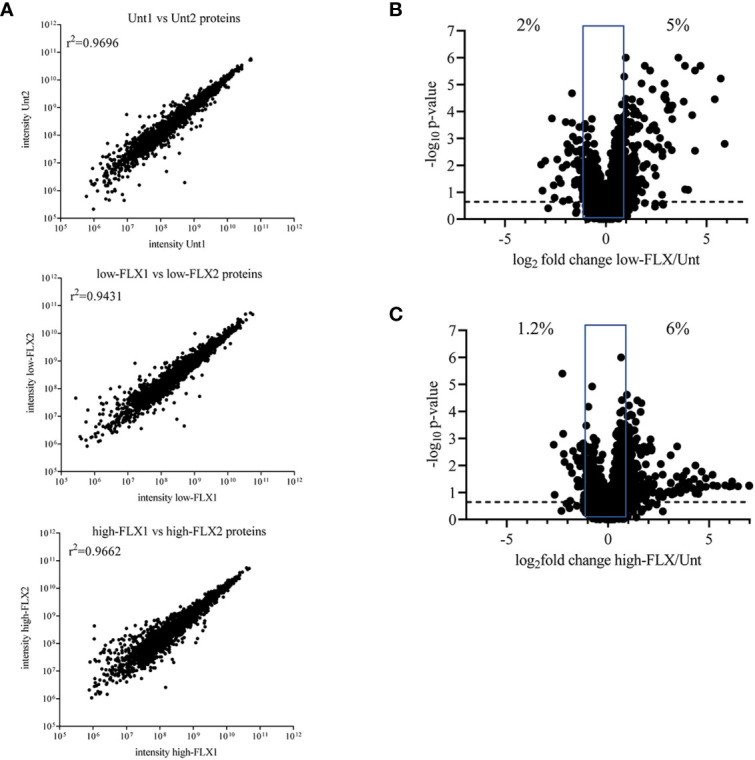
Flucloxacillin (FLX) does not significantly alter the B721-5701 cell proteome. Protein lysates were obtained from ten million B721-5701 cells treated with FLX at 150 μg/ml (low) or 453 μg/ml (high) for 5 days, or from untreated cultures (Unt), in duplicate. Samples were processed by LC-MS/MS and analyzed by Peaks 8.5 software. (A) Correlation among biological replicates. Protein abundance is represented in arbitrary units of intensity. (B, C) Increased (log2 fold change ≥ 1) and decreased (log2 fold change ≤ -1) abundance of proteins in the proteome of cells treated with low-FLX (B) or high-FLX concentration (C) compared to Unt, considering the average abundance of the two biological replicates per treatment. Percent values indicate divergence in abundance. Statistical differences were calculated by Spearman correlation. Proteome datasets are included in
Table S1
.